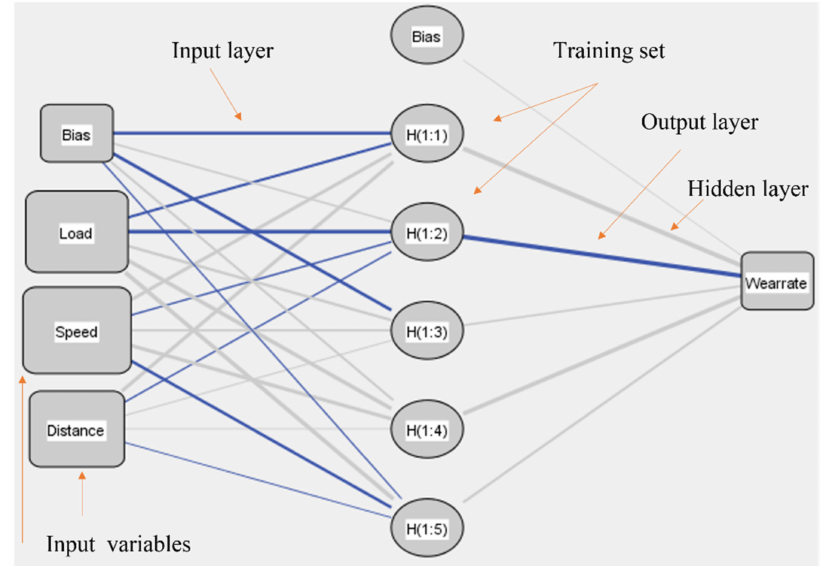
Figure 14. ANN’s architecture.